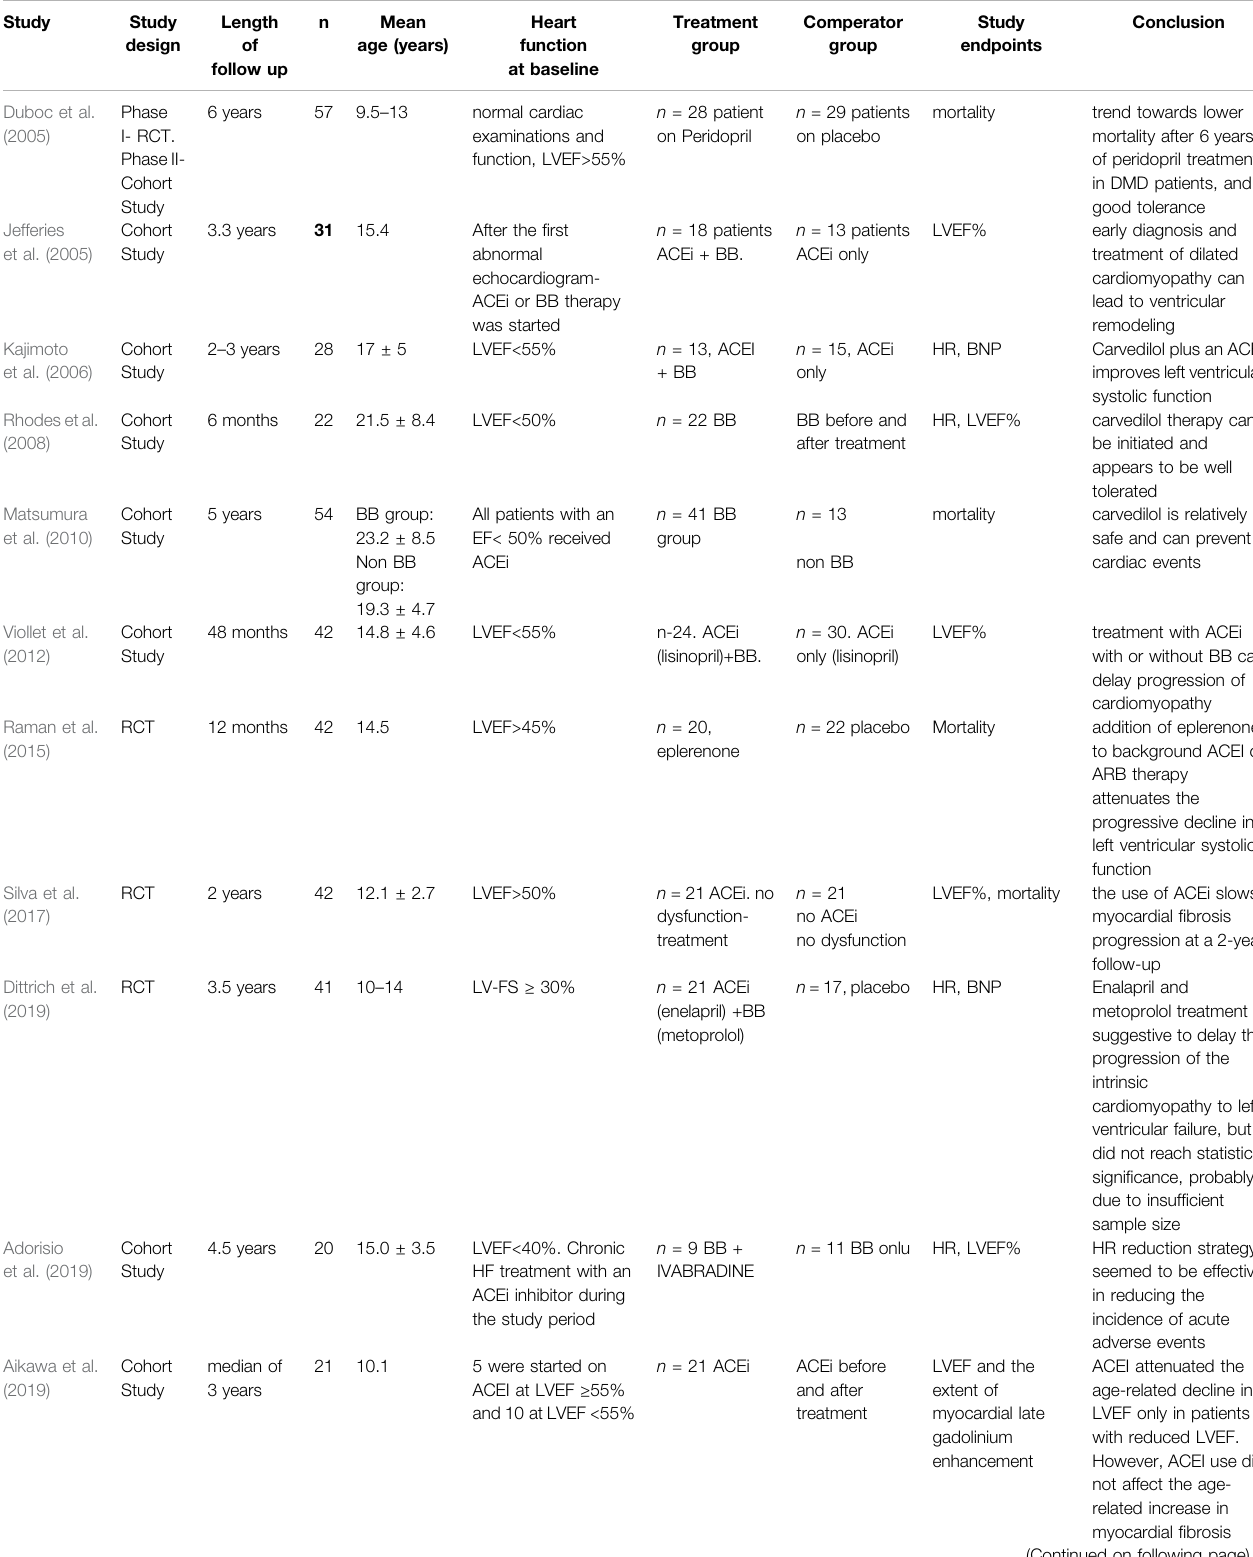
TABLE 1 | Characteristics of studies included in